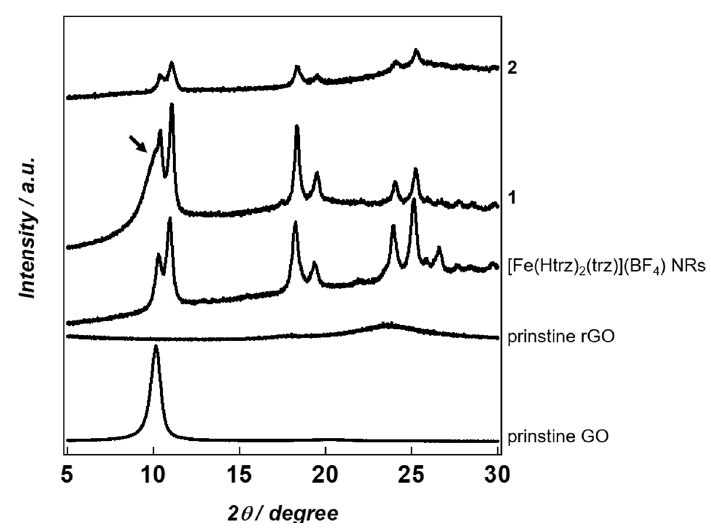
Figure 3. Powder X-ray diffraction (PXRD) patterns for pristine GO, pristine rGO, [Fe(Htrz) 2 (trz)](BF 4 ) NRs, composite 1 , and composite 2 .